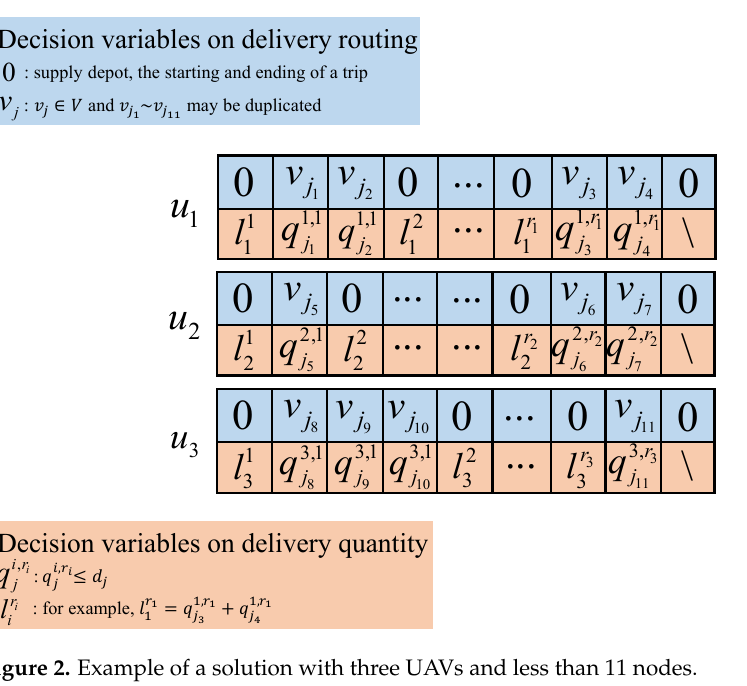
Figure 2. Example of a solution with three UAVs and less than 11